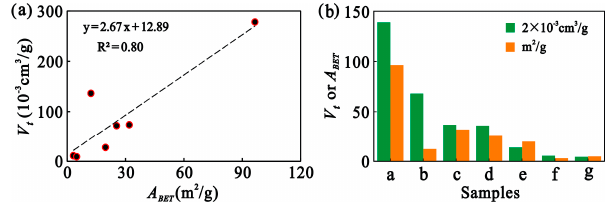
Figure 3. ( a ) Relationship between BET surface areas ( A BET ) and total pore volumes ( V t ) of clay minerals; ( b ) total pore volumes ( V t ) and BET surface areas ( A BET ) of clay minerals from LT-N 2 A/D tests (a–g: Ca-montmorillonite, kaolinite, illite/smectite mixed-layer, Na-montmorillonite, illite, cookeite and ripidolite). Table 1. Tested amounts ( q a ) of C 10 H 22 , C 7 H 14 and C 7 H 8 measured at inflection points and the q a per unit of surface area ( n BET ) for clay minerals.